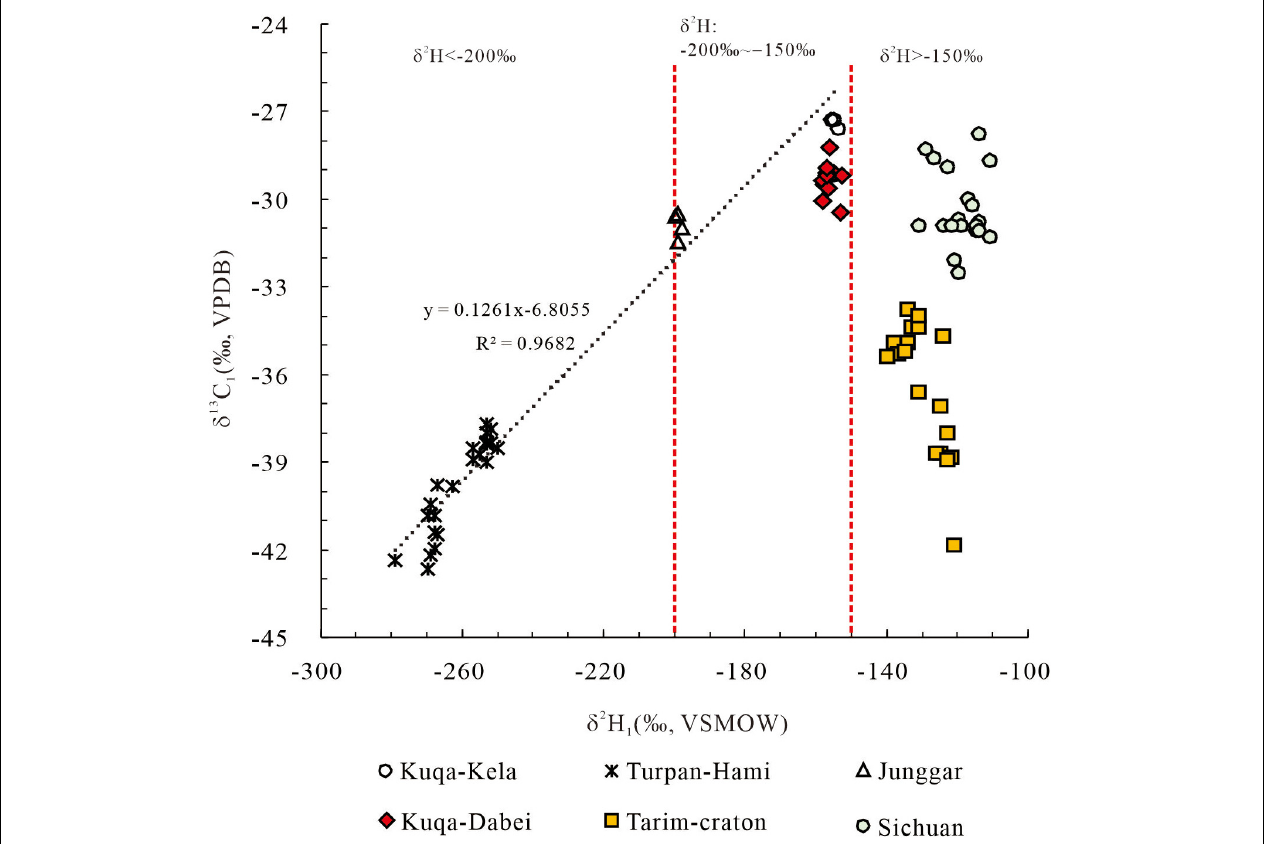
FIGURE 12 | Plot of δ 13 C 1 vs. δ 2 H 1 of gases from Dabei and Kela2 gas fields in the Kuqa depression, craton area of Tarim Basin, Turpan-Harmi and Junggar basins in China. Gas data of the Dabei and craton area of Tarim Basin see section “Samples and Methods” in text, gas data of Kela2 gas field were from Qin et al. (2007), gas data of the Turpan-Hami basin were from Ni et al. (2015) and gas data of Junggar basin were from Wang et al.